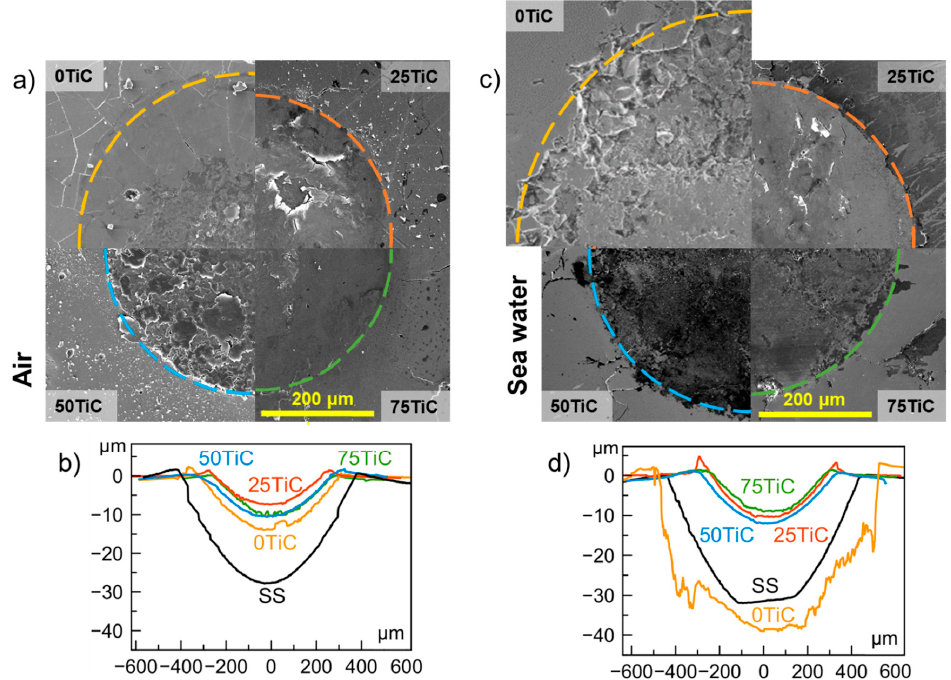
Figure 12. SEM images ( a , c ) and profiles of wear craters ( b , d ) of the coatings and steel substrate after impact testing in air and in ASW. Table 3. Sizes (radius, R, and depth, h) of wear craters of the coatings and steel substrate after impact testing in air and in ASW.